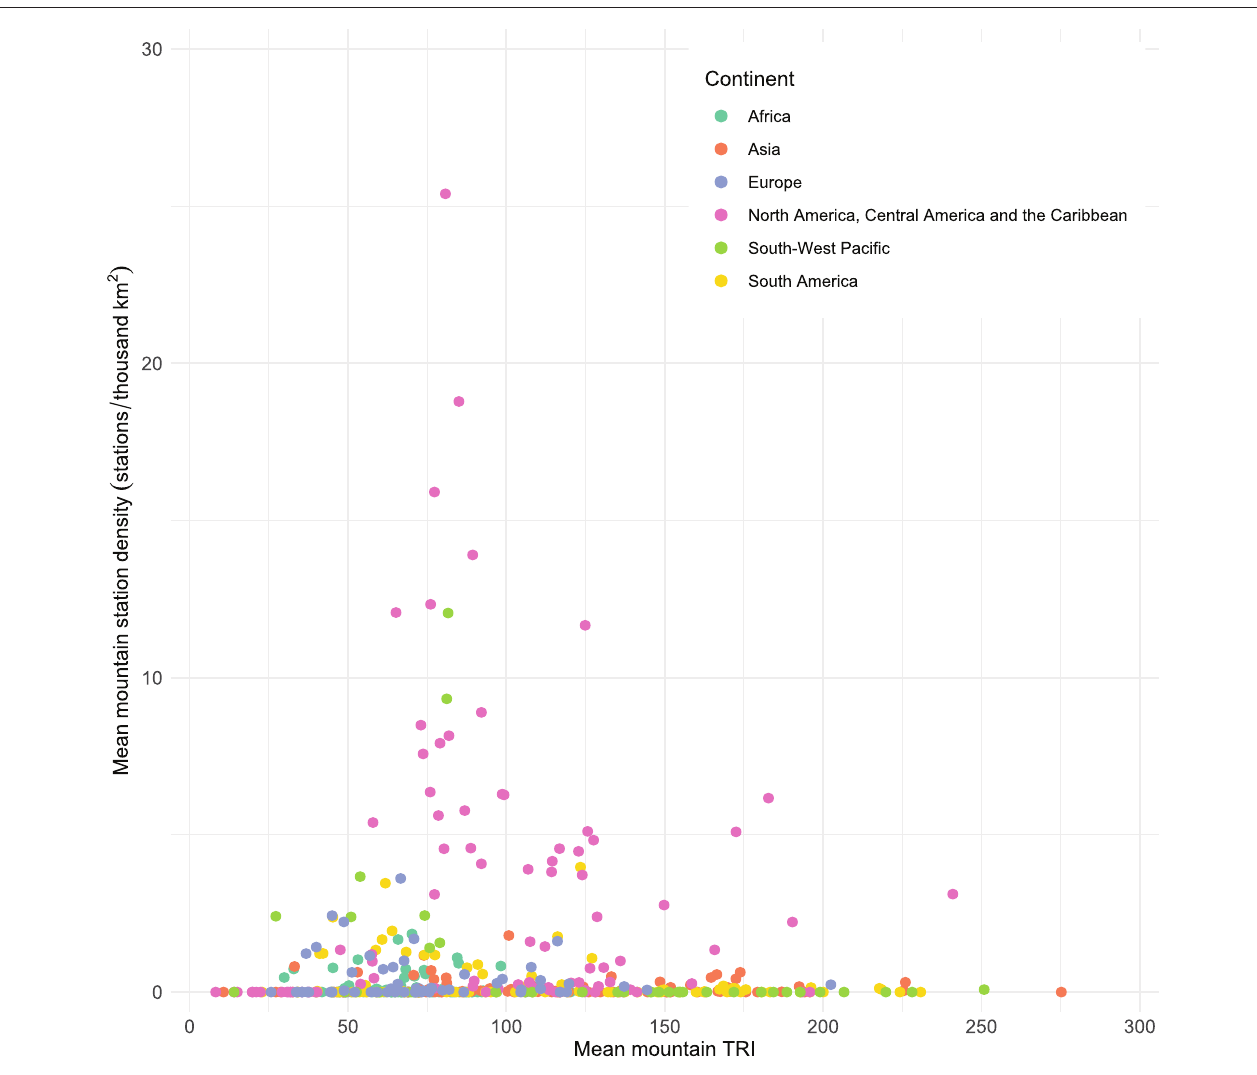
FIGURE 10 | Mean mountain GHCNd station density, irrespective of variable and record length, against mean mountain Terrain Ruggedness Index (TRI) of the mountainous part of each Major River Basin